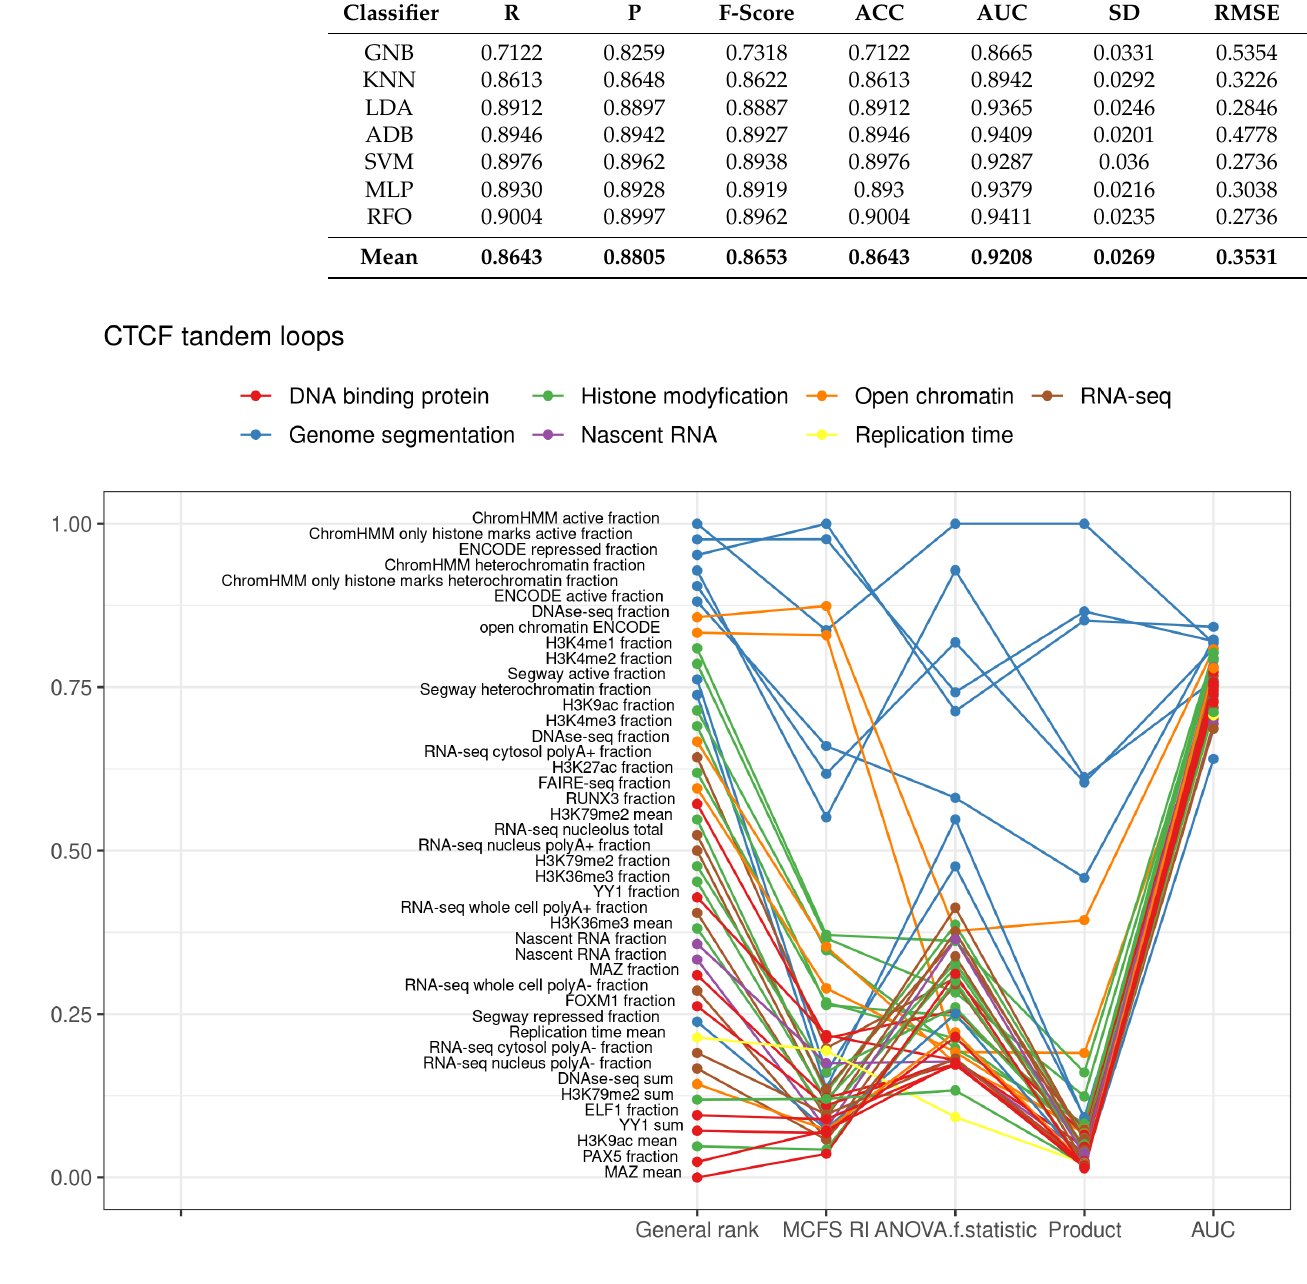
Figure 3. Top decile of the most important features for classification of CTCF tandem loops into